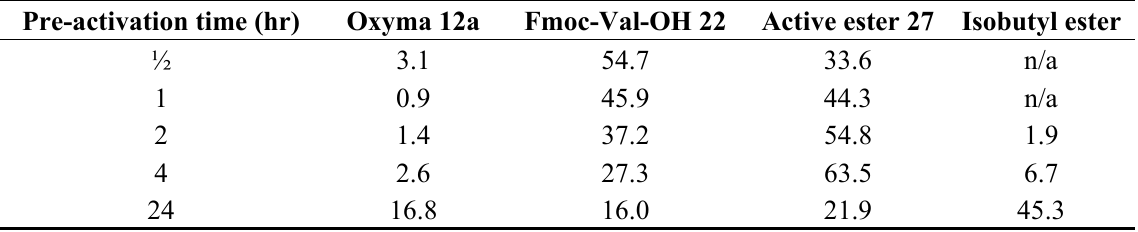
Table 5. The rate of formation of the active ester of Fmoc-Val-OH 22 using ethyl 2-cyano- 2-(isobutoxycarbonyloxyimino)acetate ( 17